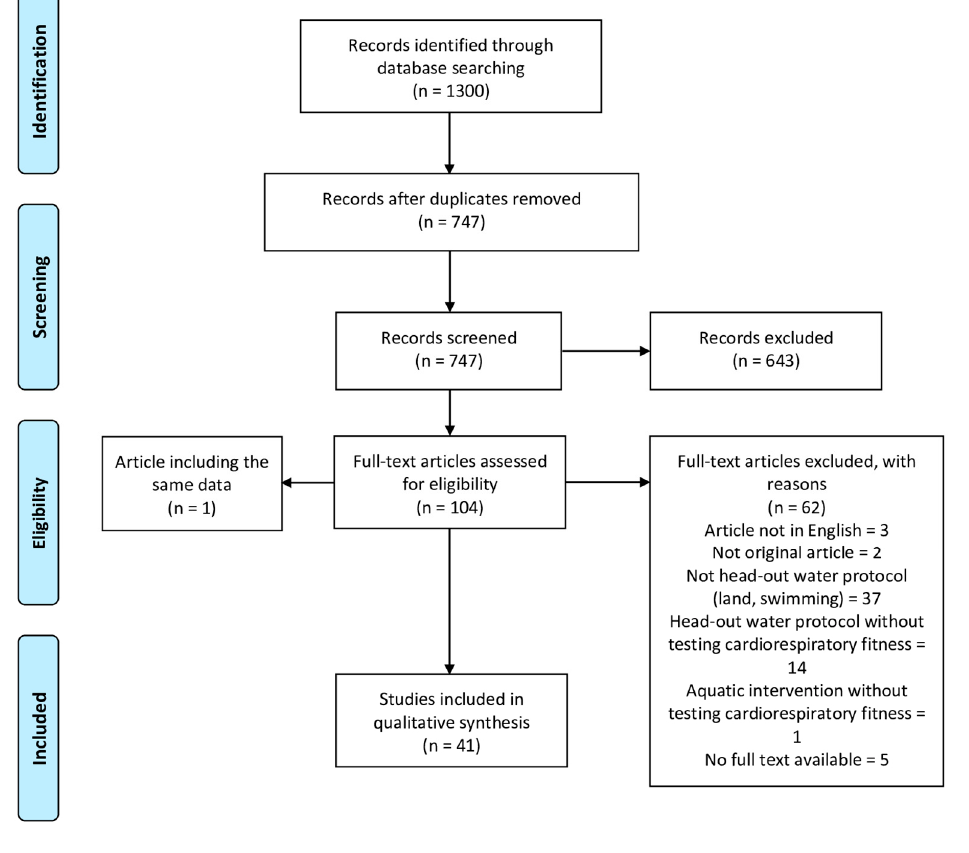
Figure 1 . Study selection flow diagram. Figure 1. Study selection flow